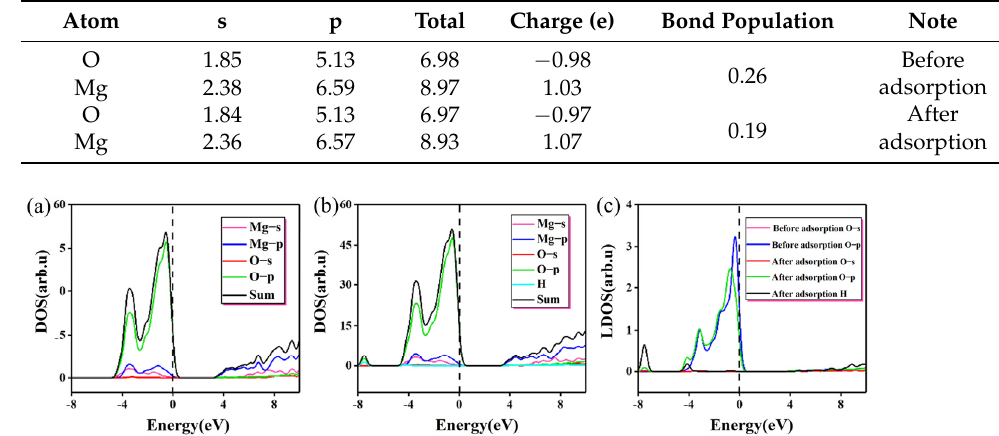
Figure 4. The change in the density of states before and after the adsorption (H up down): ( a ) the density of states before the adsorption; ( b ) the density of states after adsorption; ( c ) change in local density of states before and after adsorption at the O site.